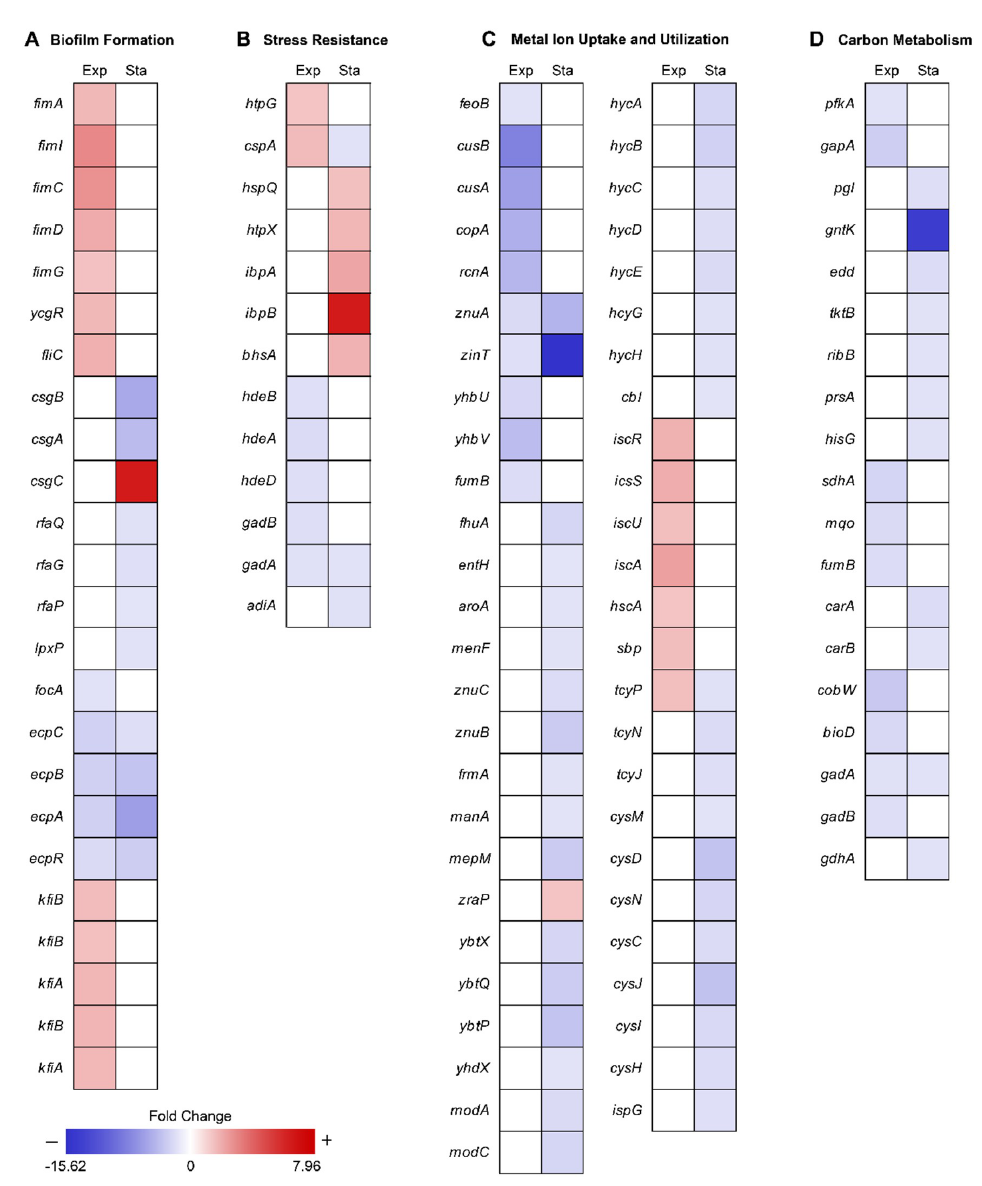
Figure 2. Hierarchical clusters diagram of the fold change ratio of DEGs for each group. Each column represents the DEGs in the exponential (Exp) and stationary (Sta) growth phase, respectively. The fold change is relative to the original value. Mean positive fold change values represent the expression ratio of MG to NG for the DEGs up-regulated under MG conditions compared to that under NG conditions and are indicated in red. Mean negative fold change values represent the expression ratio of NG to MG for the DEGs down-regulated under MG conditions compared to that under NG conditions and are indicated in blue. The gene csgC was expressed only under MG conditions during the stationary growth phase.